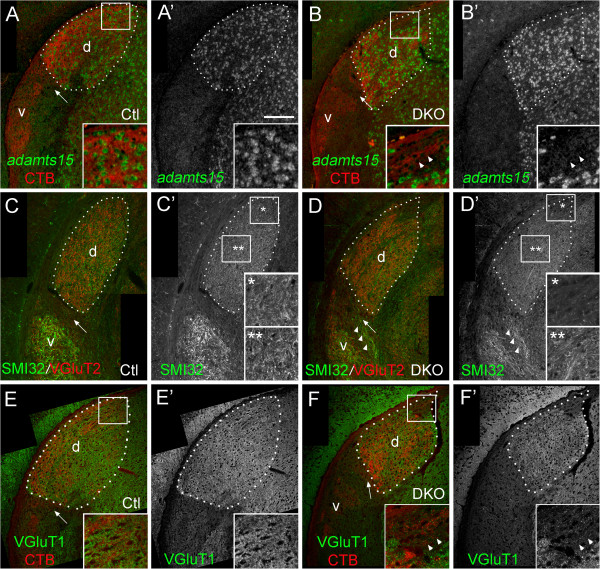
Abnormal cytoarchitecture of the dorsomedial pole of vldlr−/−;lrp8−/− mutant dLGN. Adamts15 mRNA, which is expressed by thalamic relay neurons, was labeled by in situ hybridization in (A) P14 control and (B)vldlr−/−;lrp8−/− mutant (DKO) LGN. Retinal arbors were labeled by binocular injection of Alexa Fluor 594 CTB. In (B), note the ectopic region of binocular retinal input in the dorsomedial pole of vldlr−/−;lrp8−/− dLGN is labeled with arrowheads. Insets in (A,B) show high magnification images of the areas indicated by boxes. (C,D) dLGN and vLGN relay neurons (and their dendrites) were labeled by SMI32-immunostaining and retinal terminals were labeled by VGluT2-IHC. Note the absence of SMI32-immunoreactivity in the dorsomedial pole of vldlr−/−;lrp8−/− mutant dLGN (asterisk). Also note the abnormal presence of SMI32-IR structures in vldlr−/−;lrp8−/− mutant IGL (arrowheads). Insets in (C,D) show high magnification images of the areas indicated by boxes, and single and double asterisks. (E,F) Corticothalamic terminals in control and mutant dLGN were labeled by VGluT1-IHC. Retinal arbors were labeled by binocular injection of Alexa Fluor 594 CTB. In (F), note the absence of VGluT1-immunoreactivity in the dorsomedial pole of vldlr−/−;lrp8−/− mutant dLGN (arrowheads). Insets in (E,F) show high magnification images of the areas indicated by boxes. For all images, the outline of the dLGN is depicted with white dots. dLGN are labeled ‘d’, vLGN are labeled ‘v’ and arrows indicate IGL. Scale bar = 180 μm for (A to F) and 50 μm for insets. CTB, cholera toxin B subunit; Ctl, control; DKO, double knockout; dLGN, dorsal LGN; IGL, intergeniculate leaflet; LGN, lateral geniculate nucleus; SMI32-IR, SMI32-immunoreactivity; VGluT1-IHC, vesicular glutamate transporter 1-immunohistochemistry; vLGN, ventral LGN.